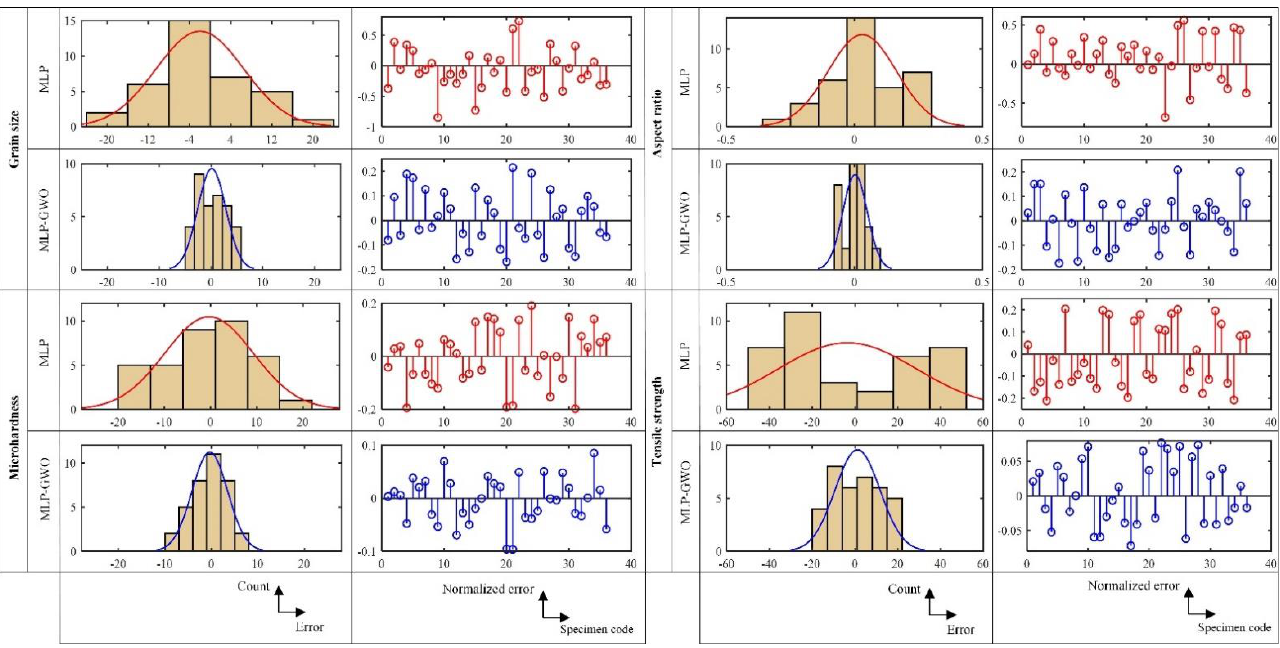
Figure 12. The normalized error plots and error histograms for all predicted responses using MLP and